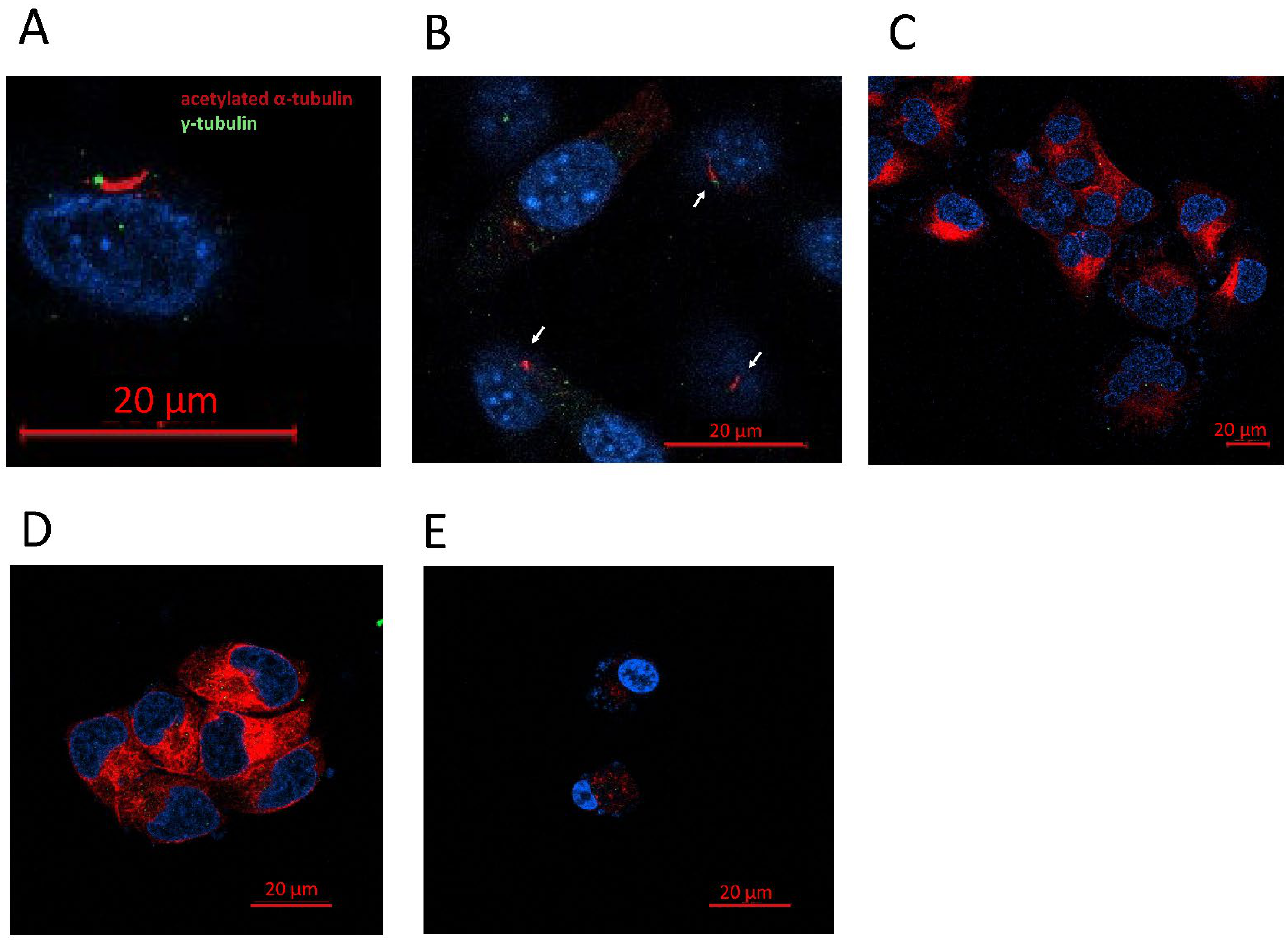
Figure 5. GBM cell lines lack a primary cilium. ( A ) Representative image of a primary cilium (NHA). ( B ) Presence of primary cilia in NHA cell line. ( C – E ) Human GBM cell lines did not present a primary cilium. ( C ) LN405, ( D ) T98G, and ( E ) U87MG.